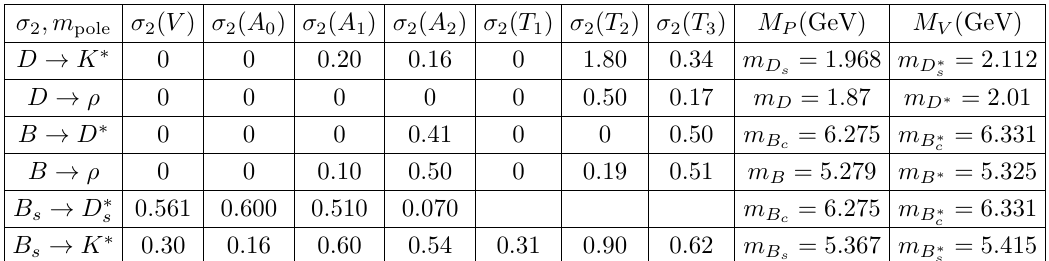
Table 15 . Part III: Best-(cid:12)t parameters for eqs. (C.8){(C.9) from refs. [63, 129].